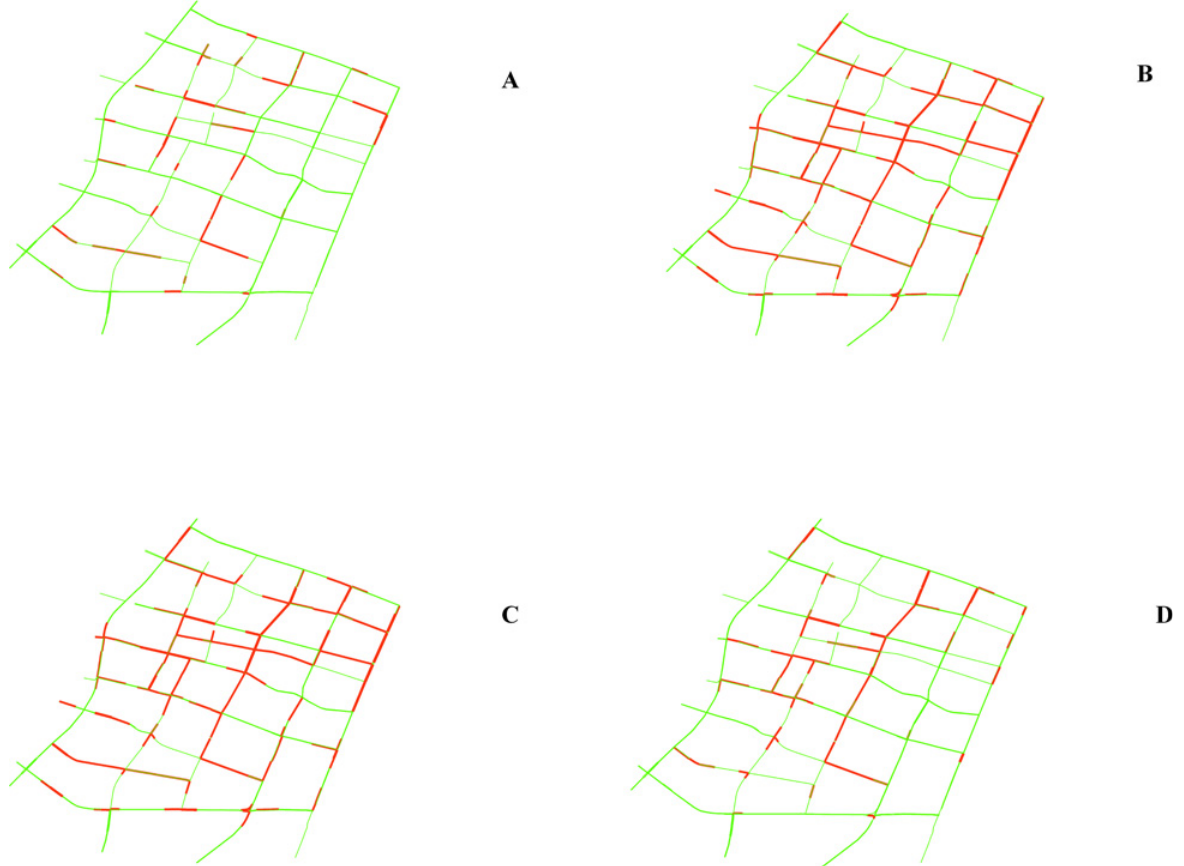
Fig 6. Predicted Network Congestion Evolution Patterns on May 09, 2014 with Varying Times of Day. (a) Spatial Distribution of Congestion from 5AM to 6AM; (b) Spatial Distribution of Congestion from 9AM to 10AM; (c) Spatial Distribution of Congestion from 5PM to 6PM; (d) Spatial Distribution of Congestion from 11PM to 12PM (Red line indicates congested traffic condition; green line indicated uncongested traffic condition).